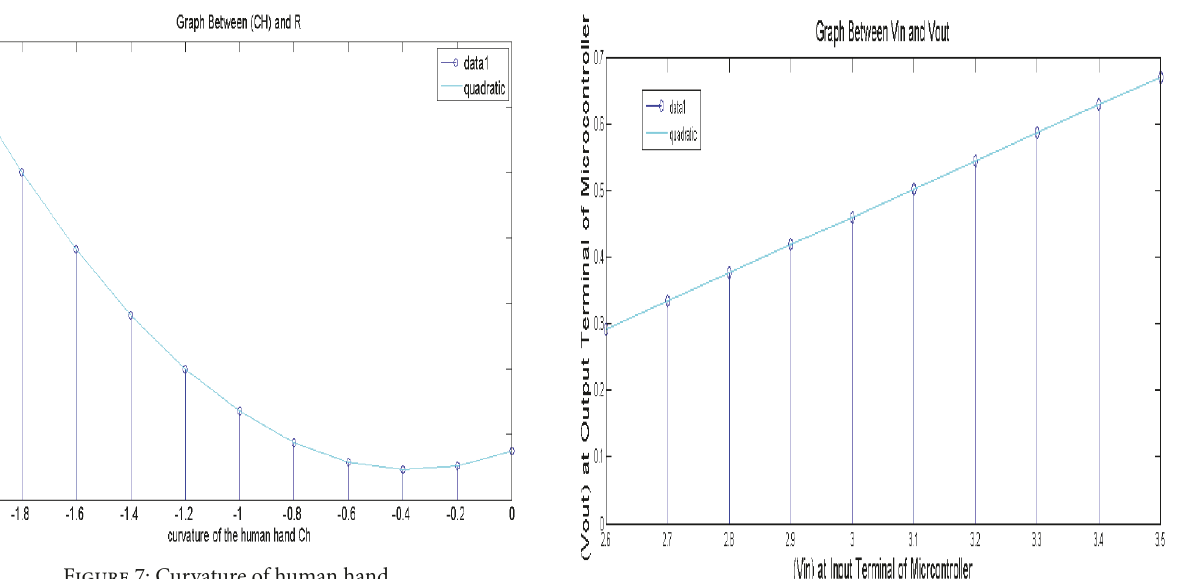
Figure 7: Curvature of human hand.